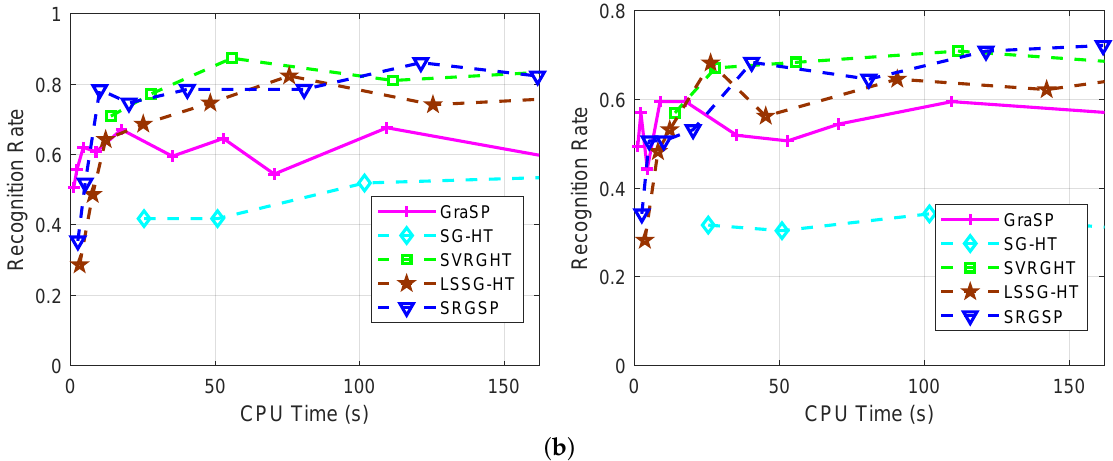
Figure 8. Recognition rates of all the algorithms on the extended Yale B (top) and AR (bottom) databases with different levels of Gaussian noise: σ = 0.25 and σ = 0.5. ( a ) The Yale B database with σ = 0.25 (left) and σ = 0.5 (right); ( b ) the AR database with σ = 0.25 (left) and σ = 0.5 (right).